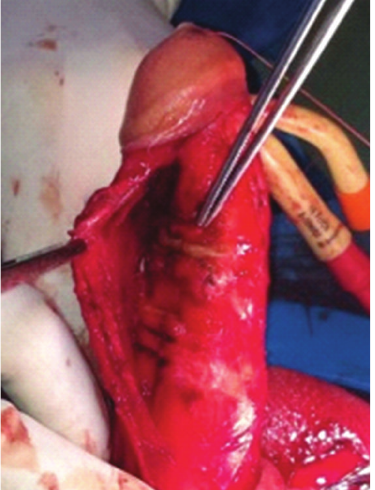
Figure2:Correctionofthedeviationfollowingthepenileprosthesis